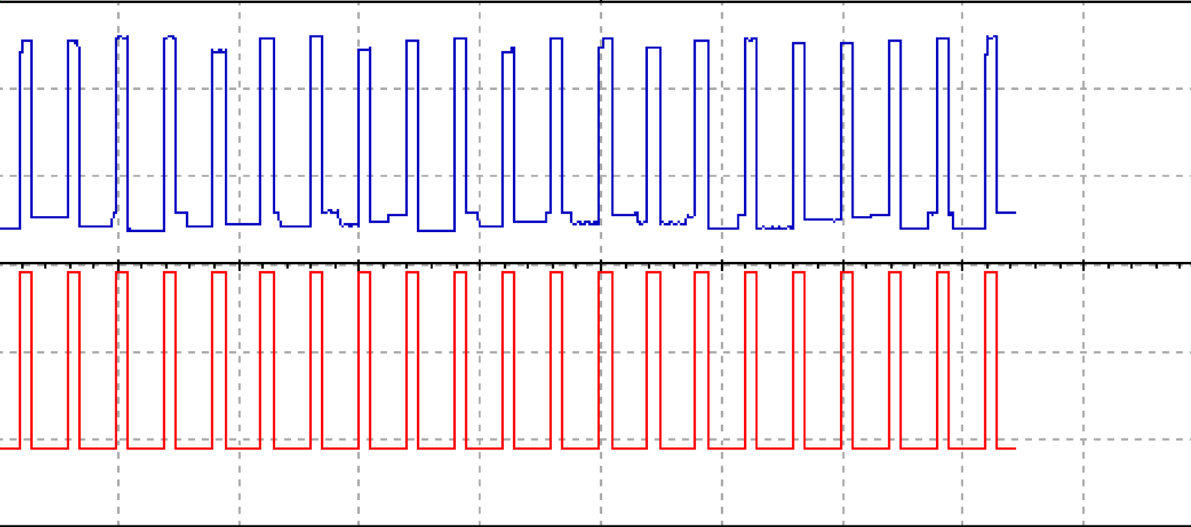
Fig. 20 Comparison of original message in red and decoded message in